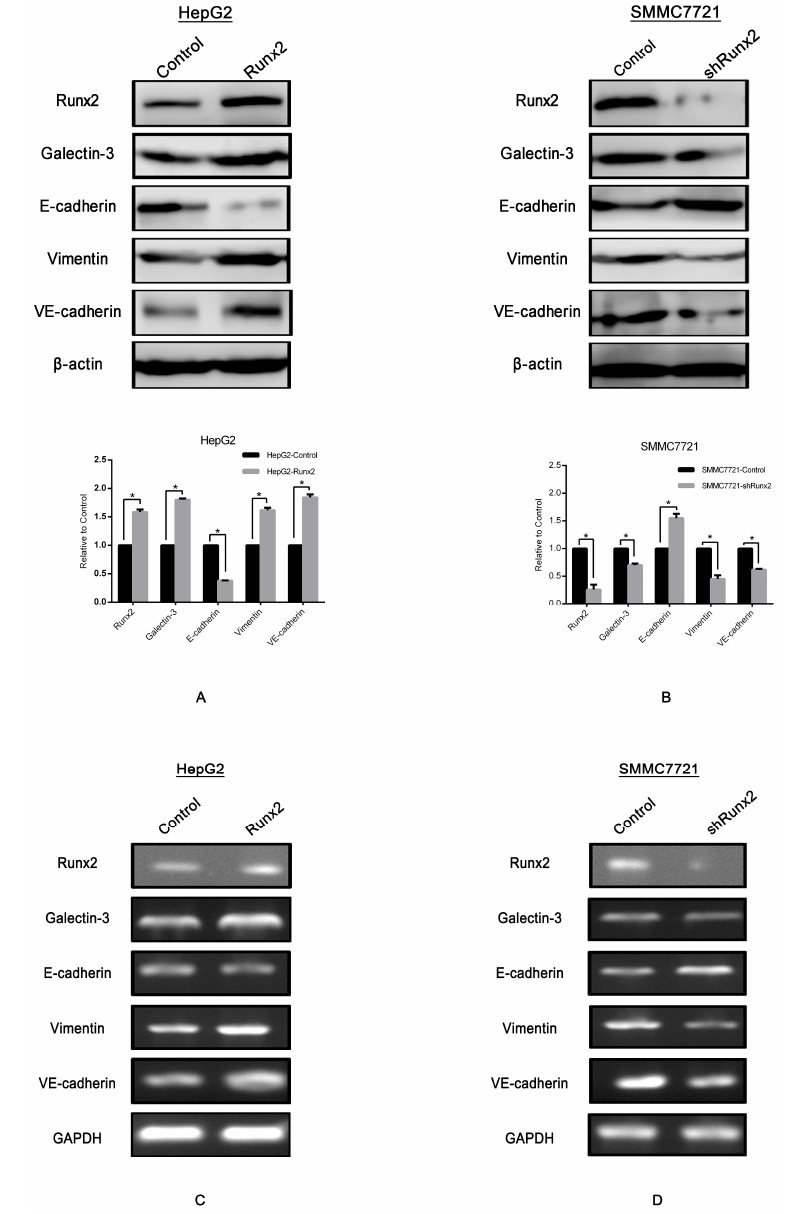
Figure 3. Western blot analysis, β -actin was used as the loading control. Protein levels of